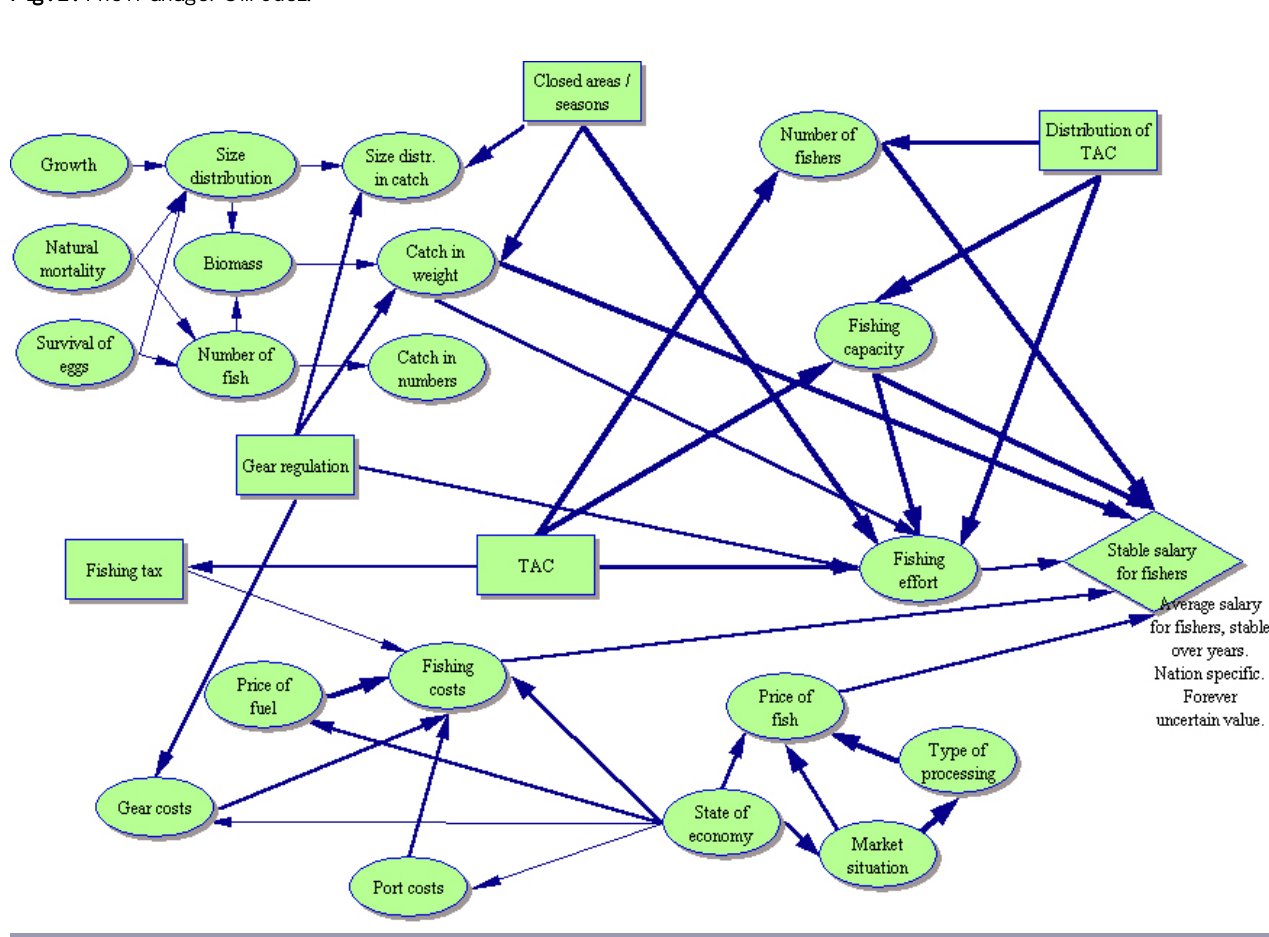
Fig. 2. The Manager’s